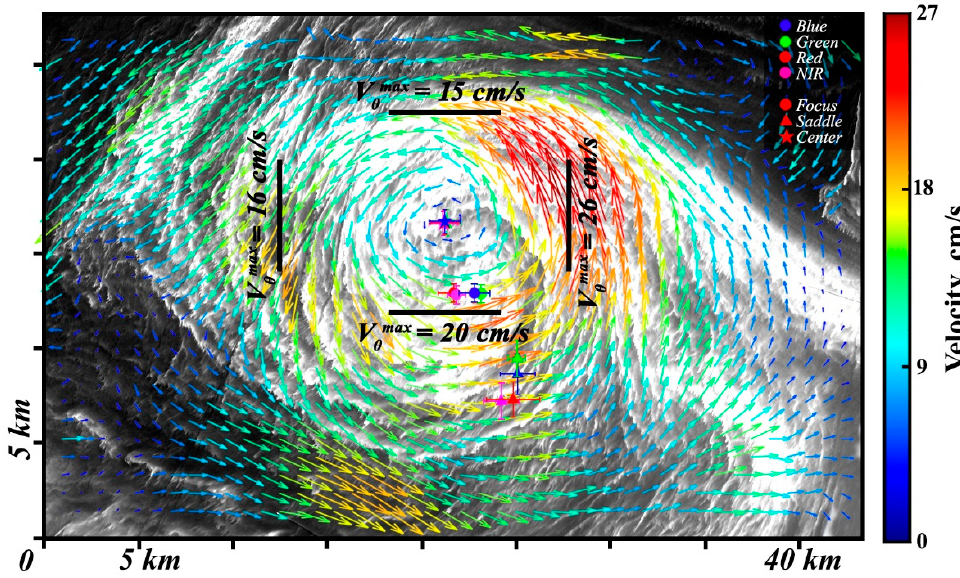
Figure 8. Velocity field after the subtraction of the mean drift component (green band); the scales of